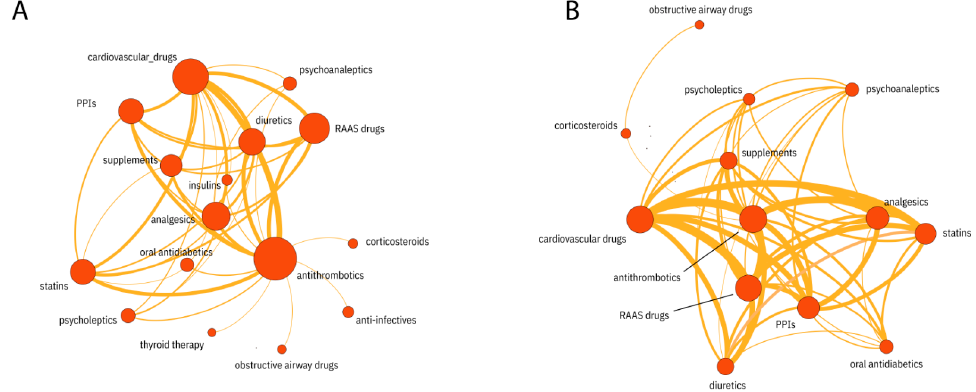
Figure 2. Drug group networks for severe ( A ) and non-severe ( B ) COVID-19 (only nodes with three or more edges are shown).